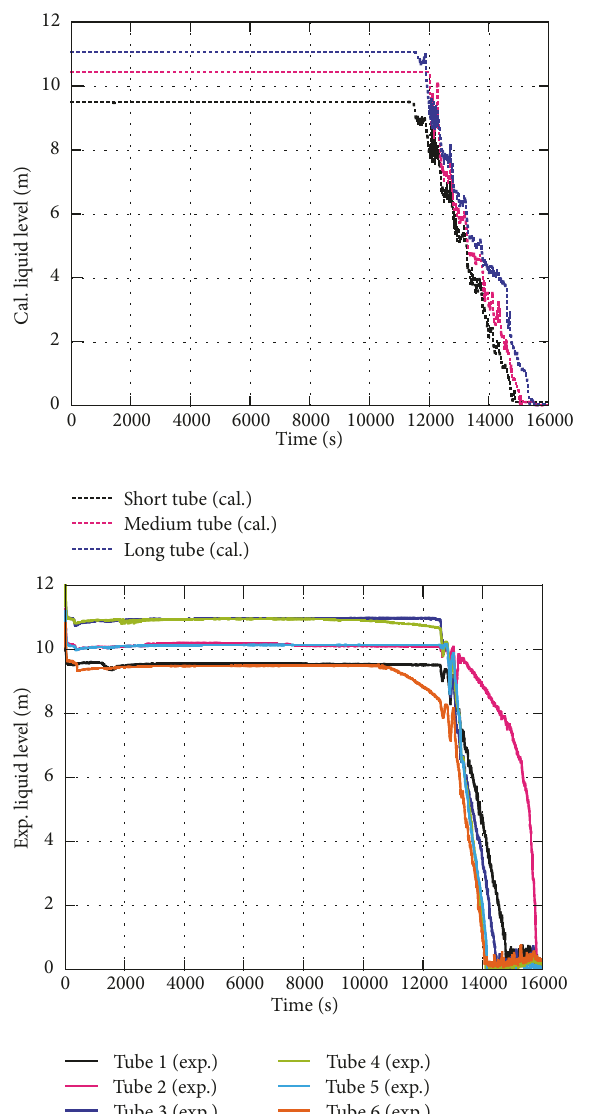
Figure28:TR-LF-16testandRELAP5resultsforSGU-tubeupflow- side collapsed liquid level in loop B.